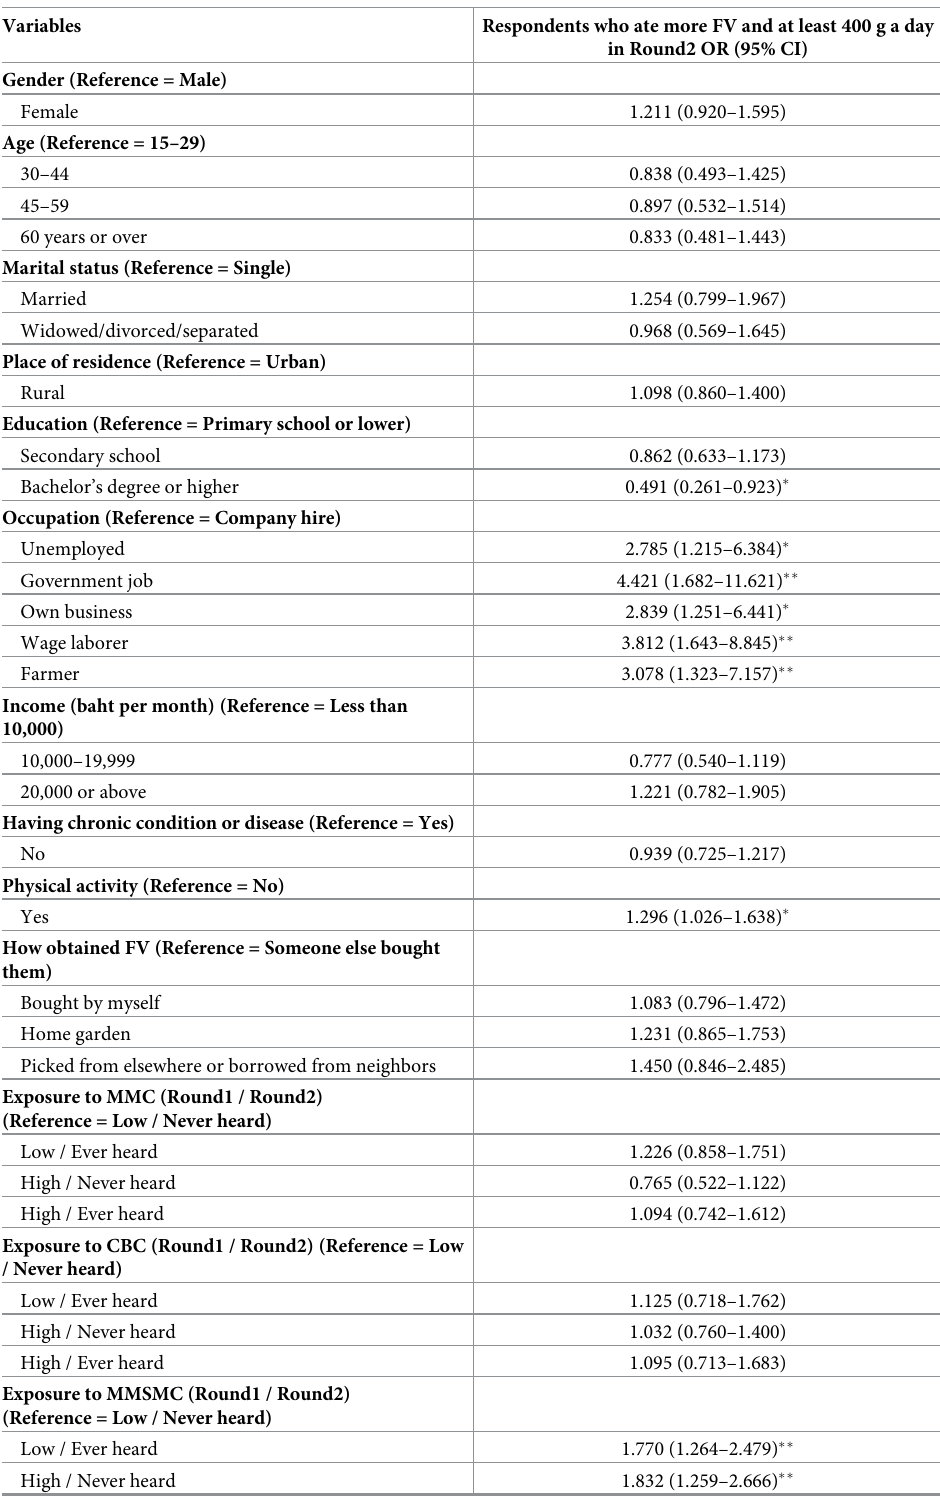
Table 5. Binary logistic regression of implementation of FV campaigns and other factors affecting increases in FV consumption and achieving the recommended level of consumption (Model 2).